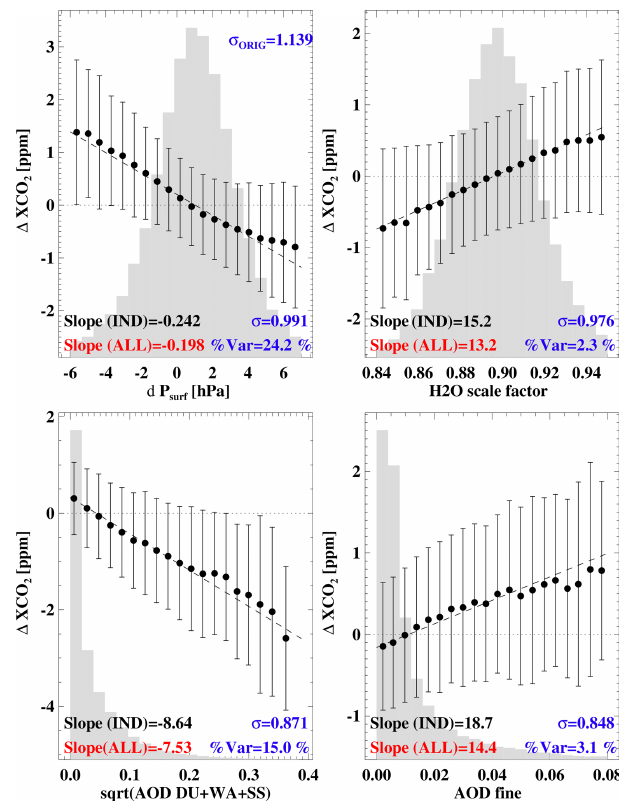
Figure 14. Final bias correction variables used for nadir–land scenes illustrating the correlation of the actual error ( (cid:49) XCO 2 de- fined as retrieved – true) as a function of variable value. The leading retrieval parameters that explain the maximum variance for land are the L2FP prior (dp), L2FP H 2 O scale factor, and two L2FP aerosol terms. The original standard deviation ( σ ) of the dataset is given in the upper part of the first panel, with the cumulative reduction in σ and percent variance explained given in the lower right.